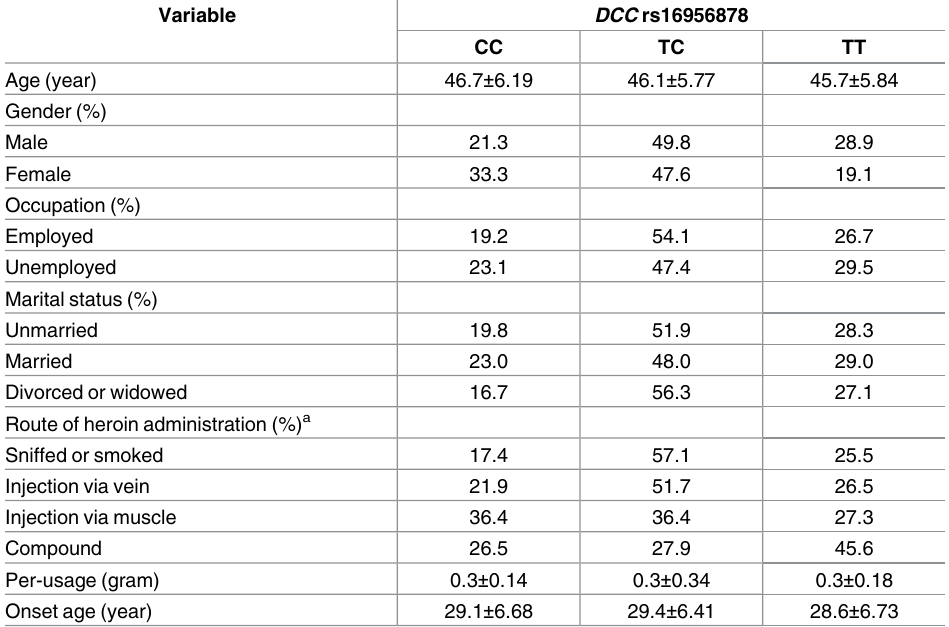
Table 3. Demographic and addiction characteristics of DCC SNP rs16956878.